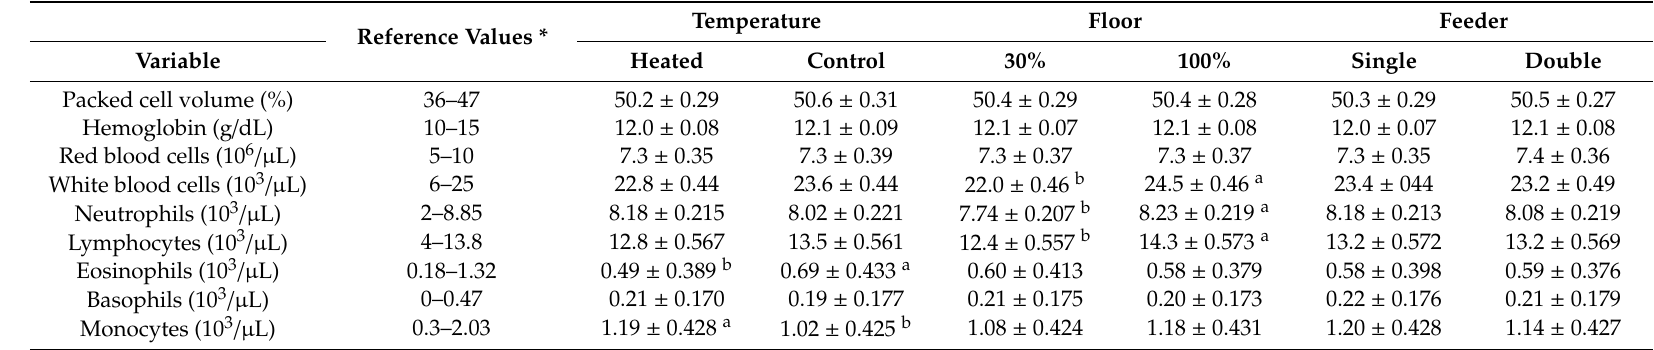
Table 3. E ff ect of temperature (heat room vs. control room), type of floor (30% slat 70% concrete vs. 100% slat), and number of feeders (one: single; two: double) on hematological parameters of pigs at the end of the